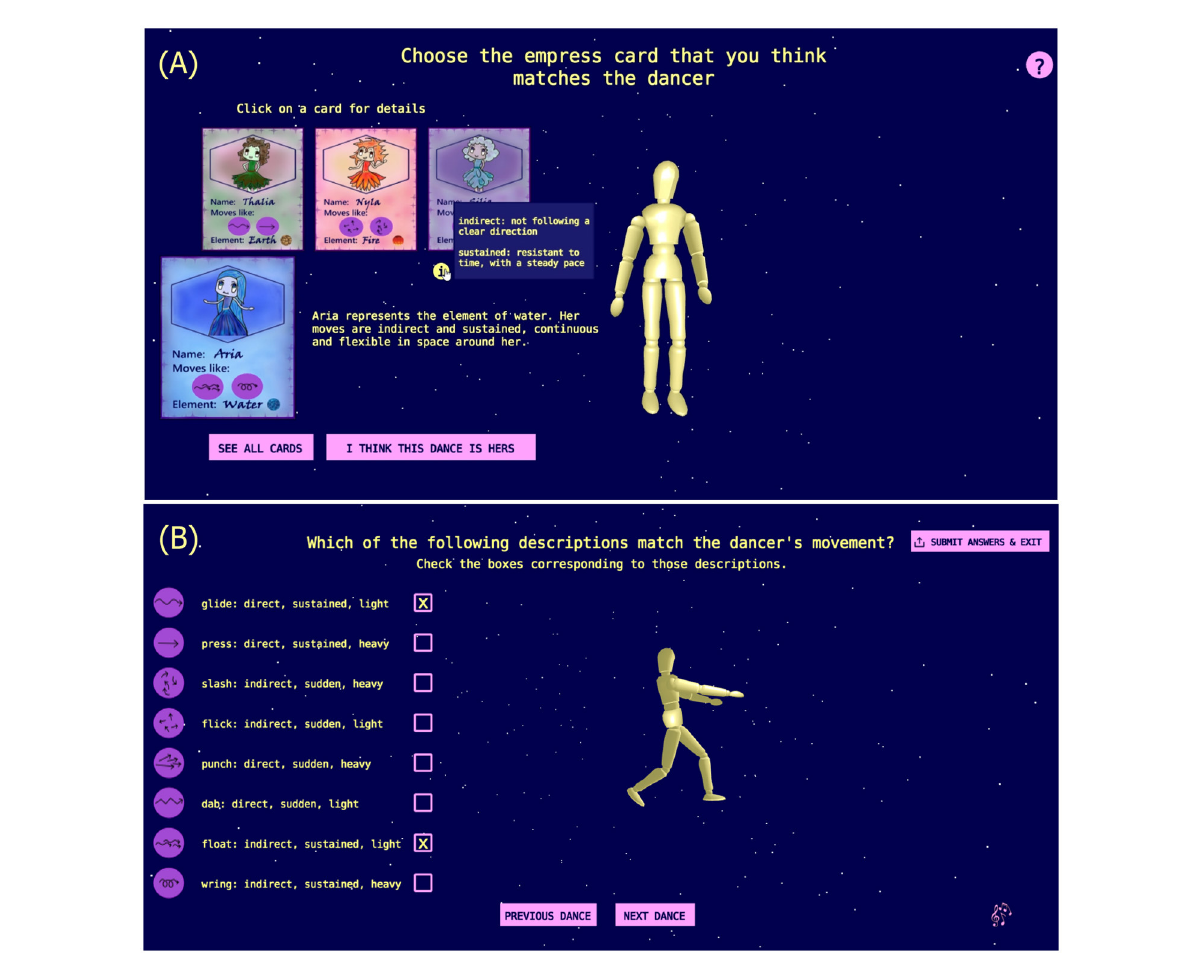
FIGURE6 Screens from the annotation processes in Story mode and Free mode. Panel (A) shows the process of assigning an empress card to the dance segment in Story mode and panel (B) shows the process of assigning matching Effort Actions to dance segment in Free